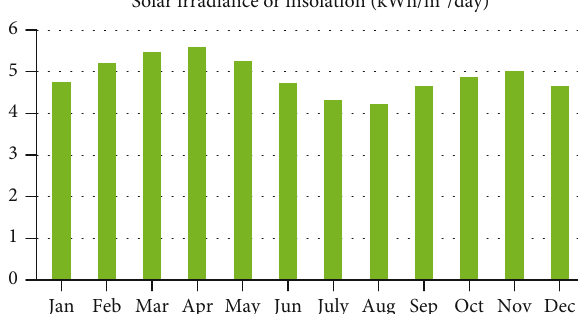
Figure 2: Ten-year monthly average solar irradiance of Bahir Dar